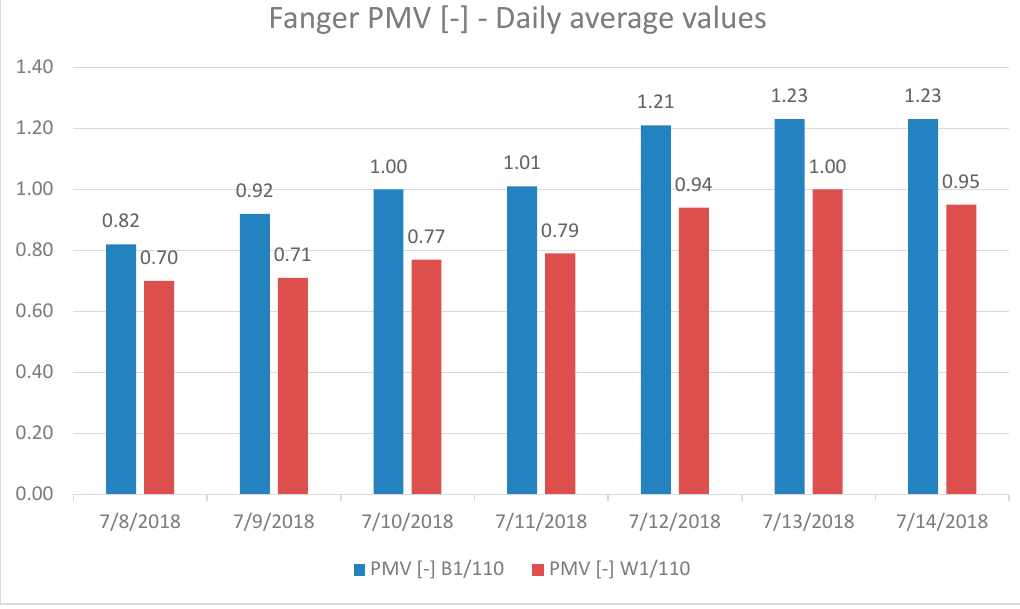
Figure 8. Thermal comfort for building B1/110.